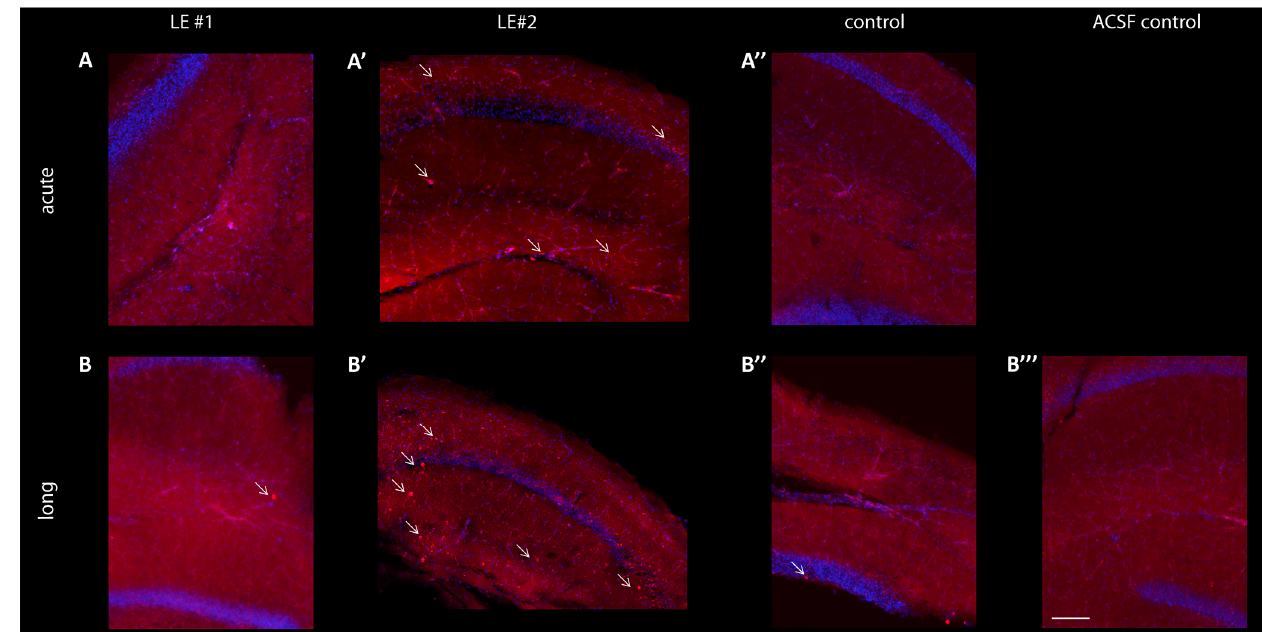
Figure 5. Reactivity of autoimmune antibodies (AB) on hippocampal slices. Representative images of Cornu Ammonis area 1 (CA1) and Dentate Gyrus (DG) of mouse hippocampal slices. Live hippocampal slices were incubated with individual patient or control sera (4.5 µg/mL). Hippocampal slice with anti-human IgG staining (red) after 1 h ( A ) of ab incubation and after 6 h ( B ). Staining of human IgGs following 1 h ( A’ ) or 6 h ( B’ ) live incubation with patient control serum (red). ( B’’ ) Hippocampal slice remaining for 6 h in ACSF. Scale bar: 200 µm.